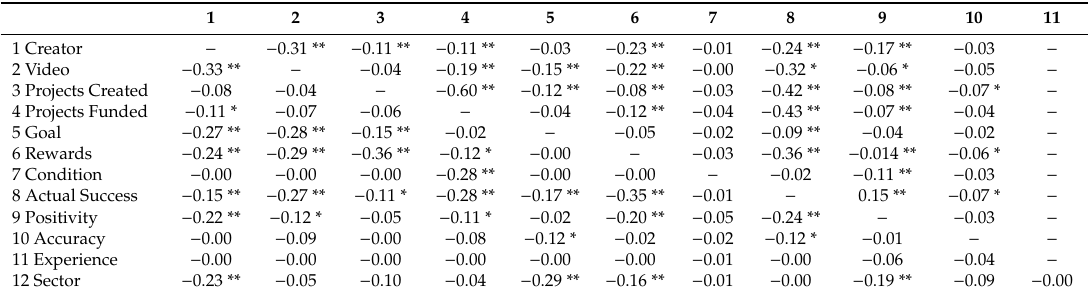
Table 2. Bivariate correlations matrix (study 1 bottom left; study 2 top right).